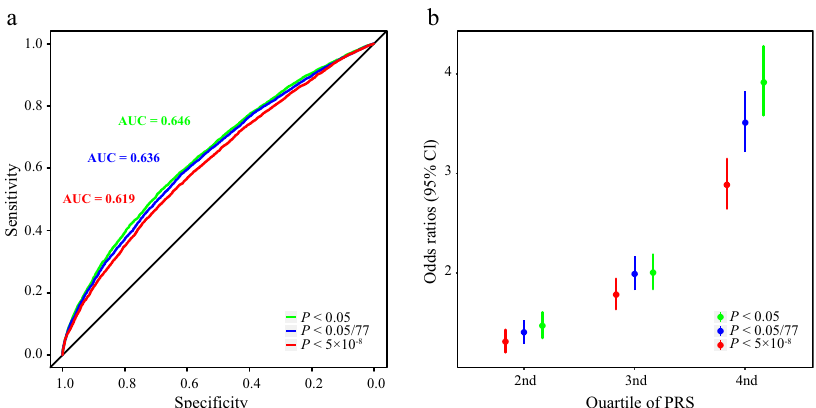
Fig. 6 Predictive model. a Polygenic risk score (PRS) receiver-operator curves for variants with different signi fi cance levels. b Odds ratio of developing PD for each quartile of the PRS compared with the lowest quartile of genetic risk. Red lines and dots correspond to data calculated from variants with P < 5 × 10 − 8 , blue lines and dots correspond to data calculated from variants with P < 0.05/77, and green lines and dots correspond to data calculated from variants with P <